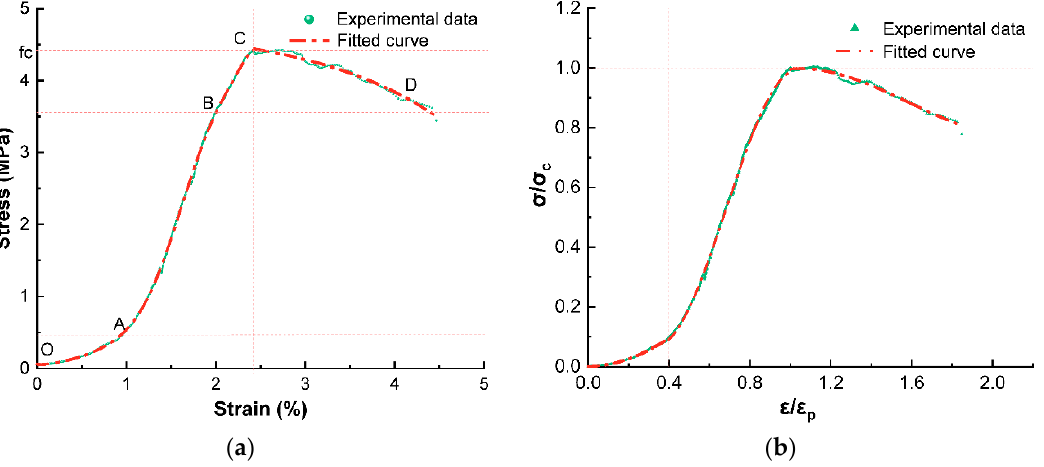
Figure 12. ( a ) The stress-strain curve of foam concrete with optimized mix ratio. ( b ) Dimensionless stress-strain curve of foam concrete with optimized mix ratio.